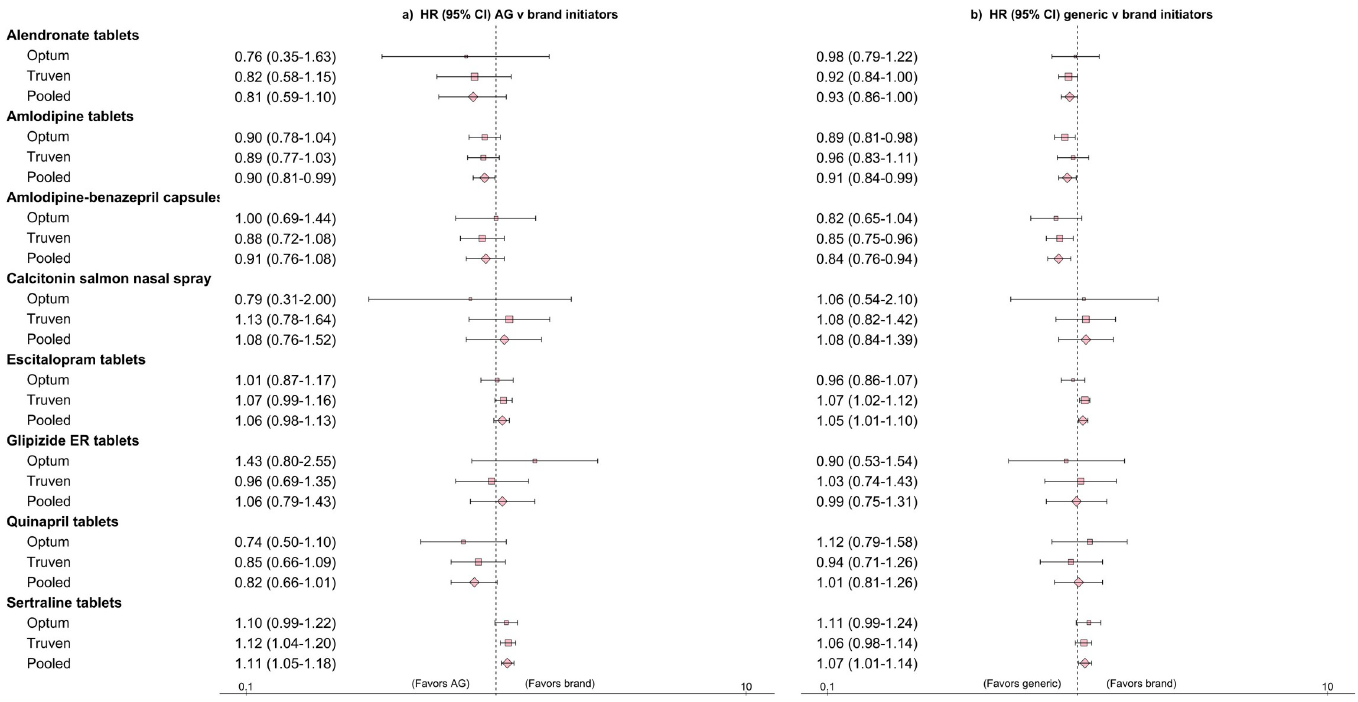
Fig 3. Hazard ratios (HRs) and 95% confidence intervals (CIs) comparing outcomes for authorized generic (AG) versus brand initiators and generic versus brand initiators after 1:1 propensity score matching in each database. The outcome for amlodipine tablets, amlodipine-benazepril capsules, and quinapril tablets was a composite endpoint comprising hospitalizations for myocardial infarction, ischemic stroke, or coronary revascularization procedures. The outcome for alendronate tablets and calcitonin salmon nasal spray was a composite non-vertebral fracture endpoint comprising humerus, wrist, hip, or pelvis fractures. The outcome for escitalopram tablets and sertraline tablets was hospitalization with a psychiatric condition as the principal discharge diagnosis code. The outcome for glipizide extended release (ER) tablets was initiation of insulin during the follow-up